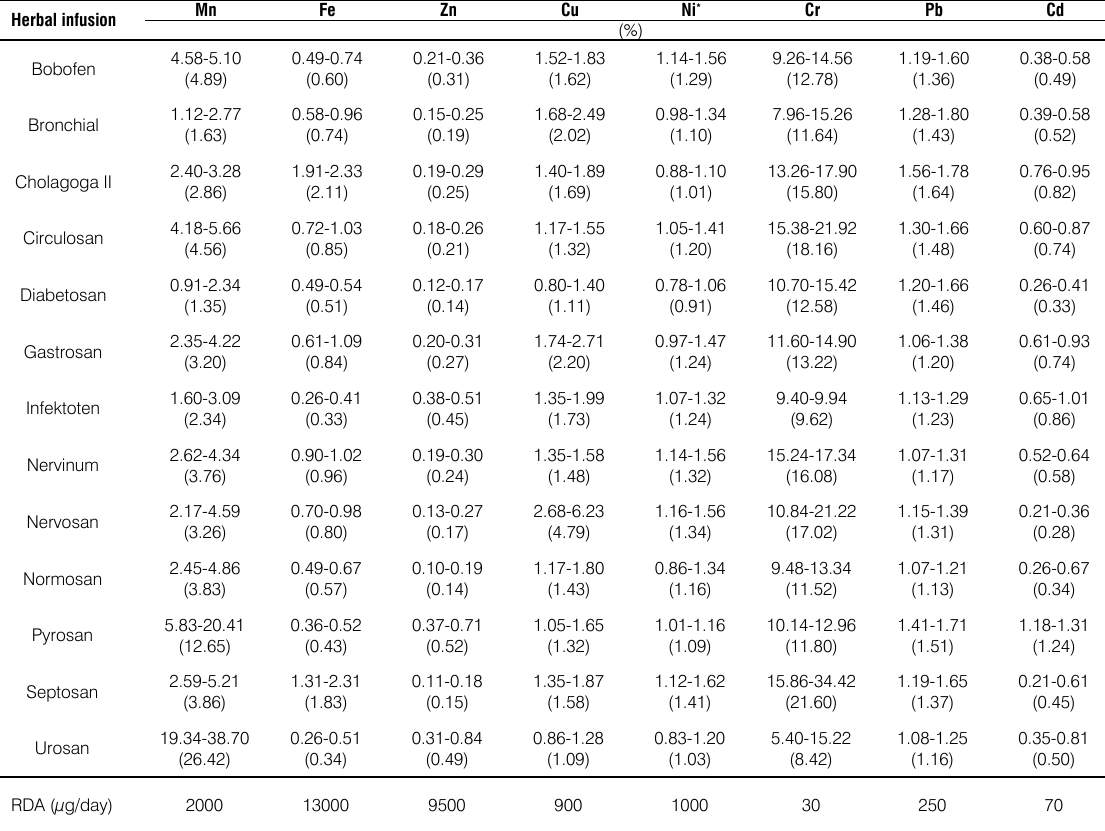
Table 2. Daily intakes of trace elements in reference to recommended dietary allowances through recommended taking of herbal